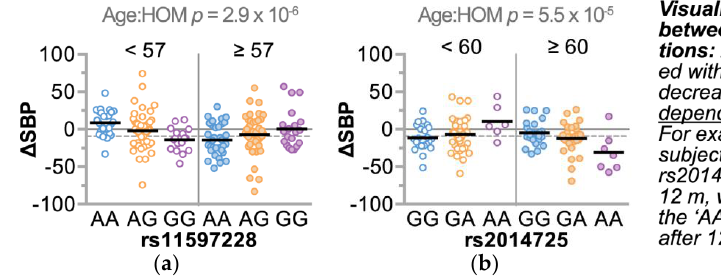
Figure 6. SNP – age interactions associated with a change in blood pressure after 12 months of the intervention. T he change in SBP (ΔSBP ) after 12 months of the intervention in either ( a ) AA or ( b ) CAU study participants ( n = 193 and 123, respectively), represented by dot plot and summarized by the median. To demonstrate the SNP-age interaction, each cohort was stratified over the median age. The p value of the association of the interaction between age and the HomSNP variable (Age:HOM) with ΔSBP for each SNP is indicated. The dashed line represents the mean ΔSBP for each cohort. Table 5. Loci with multiple SNPs that associate with ΔSBP in the AA cohort. The dbSNP identifier (ID), description of region, associated gene, chromosome (chr), and position in GRCh37 of the SNP main effects and SNP- age interactions that associated with ΔSBP are indicated by arrows.